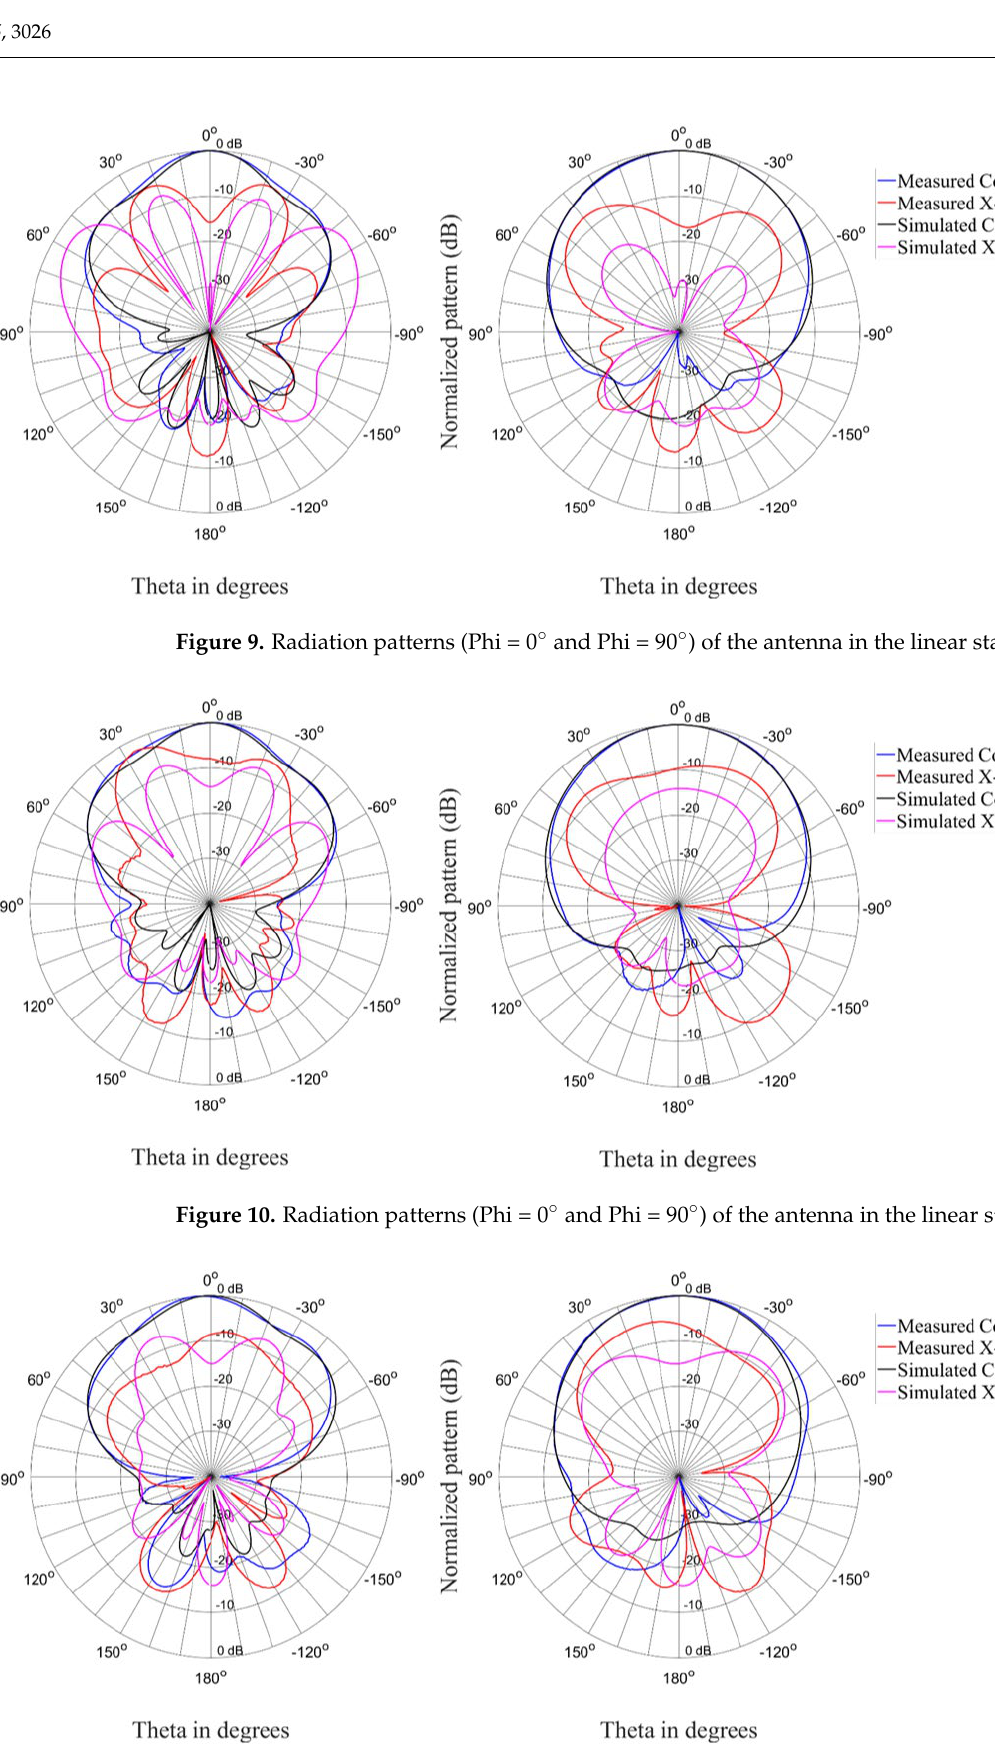
Figure 12. Radiation patterns (Phi = 0° and Phi = 90°) of the antenna in the circular state at 2.35 GHz.